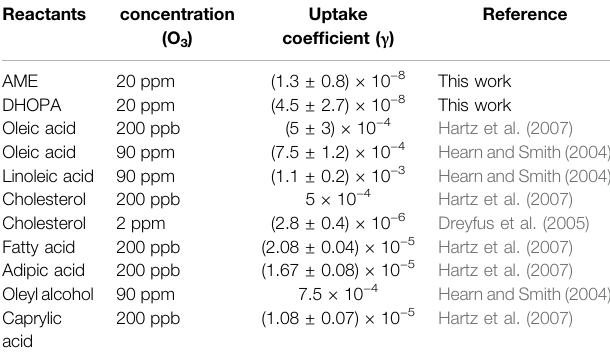
TABLE 3 | Uptake coef fi cients of ozone on surface of organic